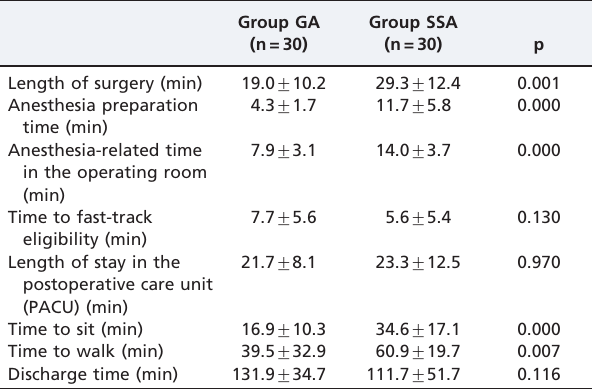
Table 2 - Intergroup analysis of parameters associated with